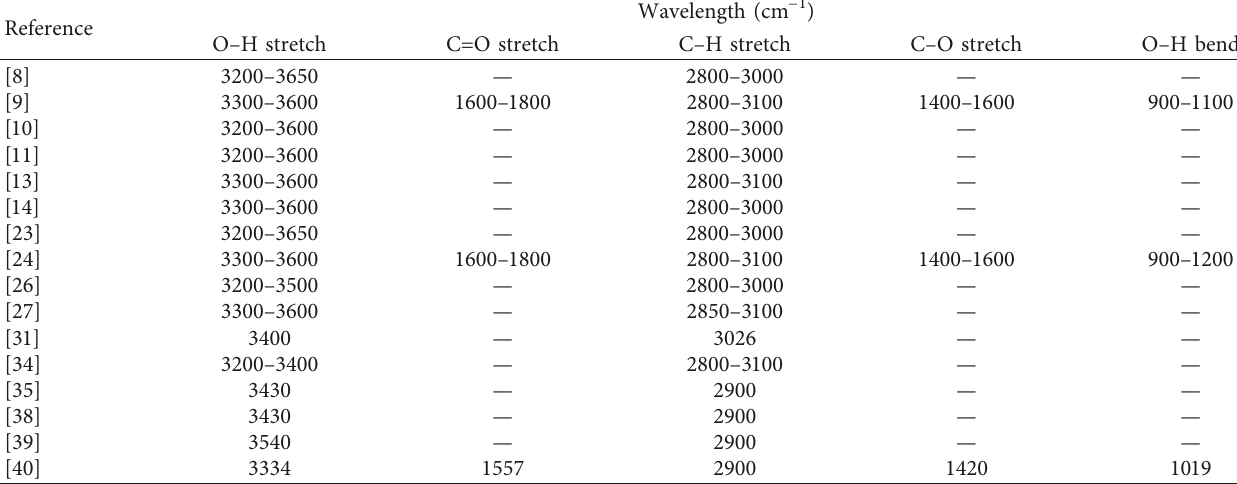
Table 9: Summary of FTIR wavelengths detected in conditioned GFRP reinforcing bars.